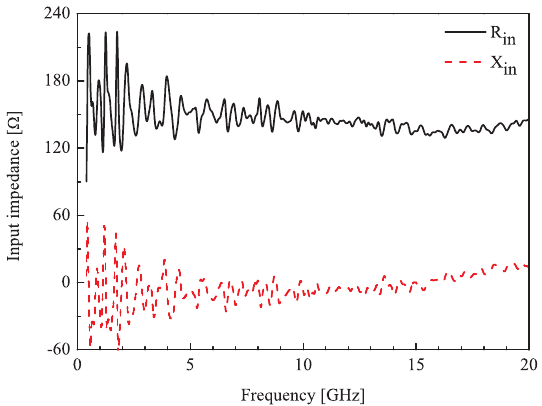
Figure 3. Input impedance of the proposed antenna as simulated by a lumped port.